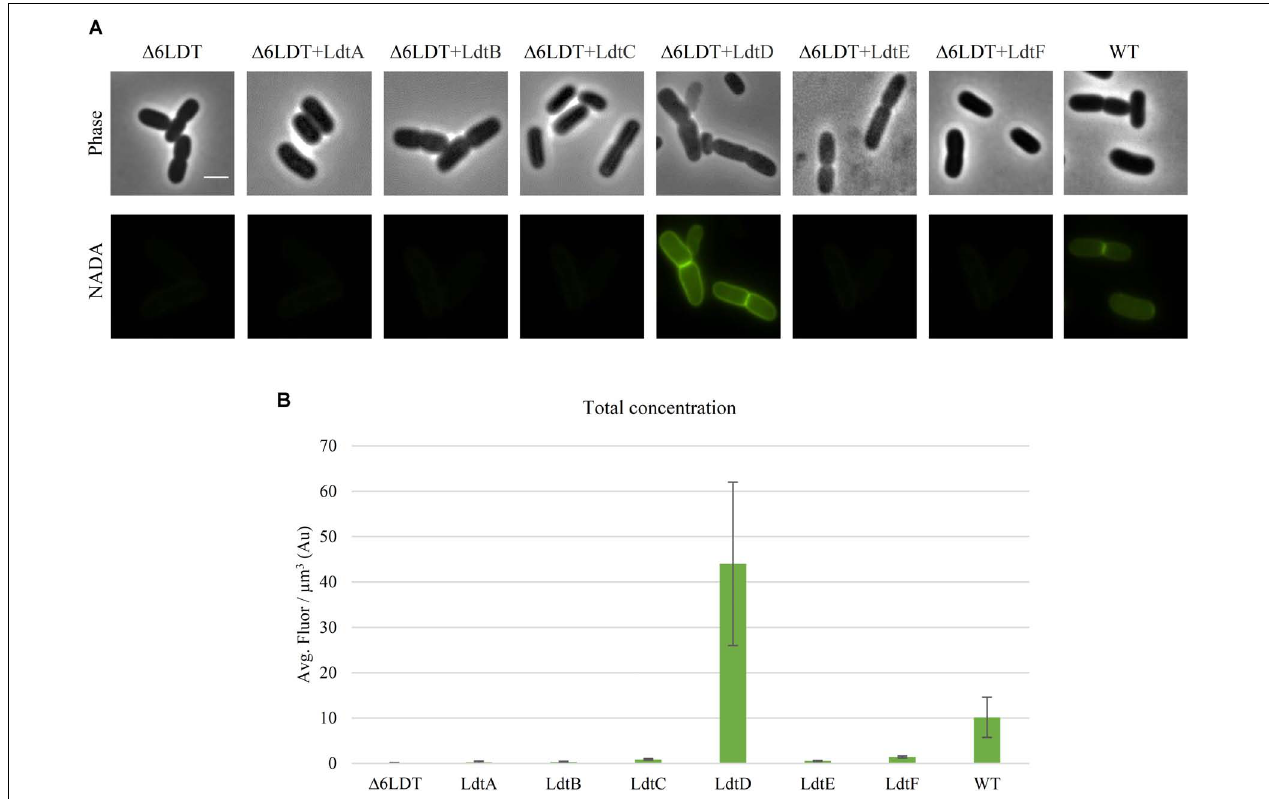
FIGURE 1 | LdtD is the main LD-TPase incorporating NADA at neutral pH during exponential growth. (A) Phase contrast and corresponding fluorescence images of cells of BW25113 (cid:49) 6LDT (control), BW25113 (cid:49) 6LDT expressing ldtA–F (from left to right), and BW25113 in the presence of 0.5 mM NADA. Cells were grown to exponential phase in LB at 37 ◦ C. ldtD expression was induced for two mass doubling times with 50 µ M IPTG, and the NADA pulse was for 20 min. Scale bar, 2 µ m. (B) Quantification of the cellular concentration of incorporated NADA in the BW25113 (cid:49) 6LDT strain not expressing (control) ( n = 345) or expressing ldtA ( n = 390), ldtB ( n = 309), ldtC ( n = 620), ldtD ( n = 368), ldtE ( n = 846), or ldtF ( n = 423) and in BW25113 cells ( n = 305). The values are mean ± SD of n number of